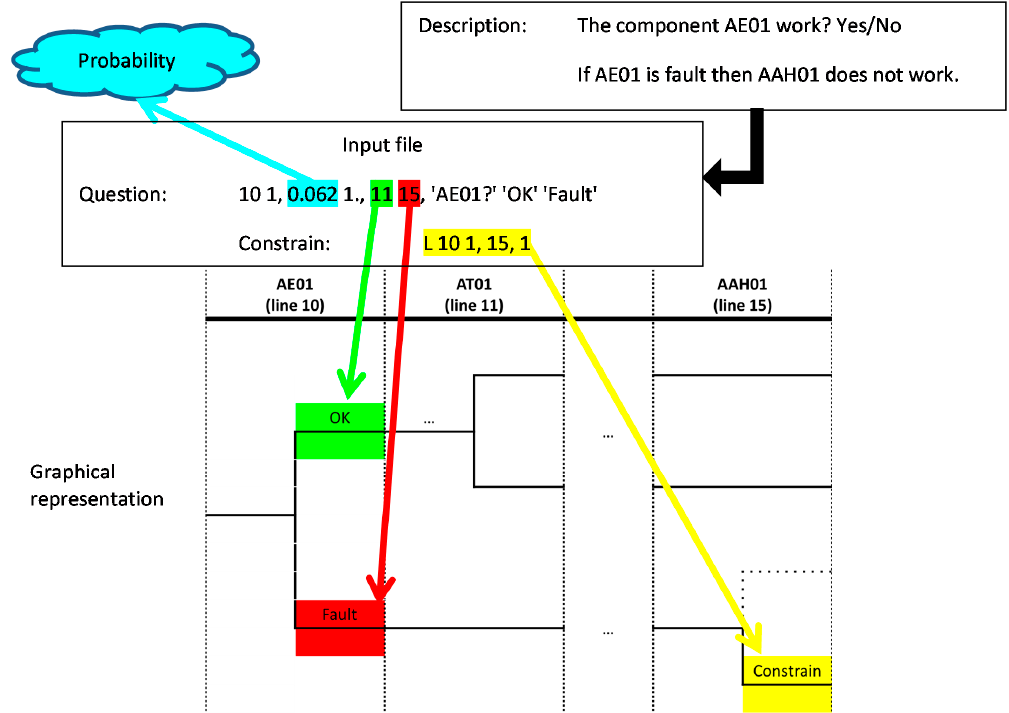
Figure 3. Graphical representation of the logical analyses structure.